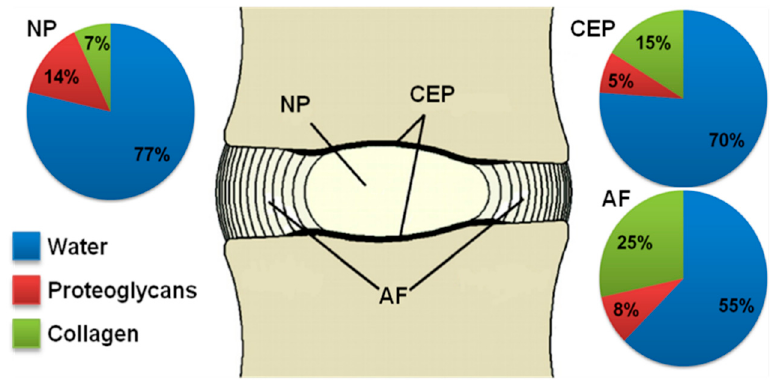
Figure 1. Biochemical composition of disc tissues ([46], adapted from [47]).